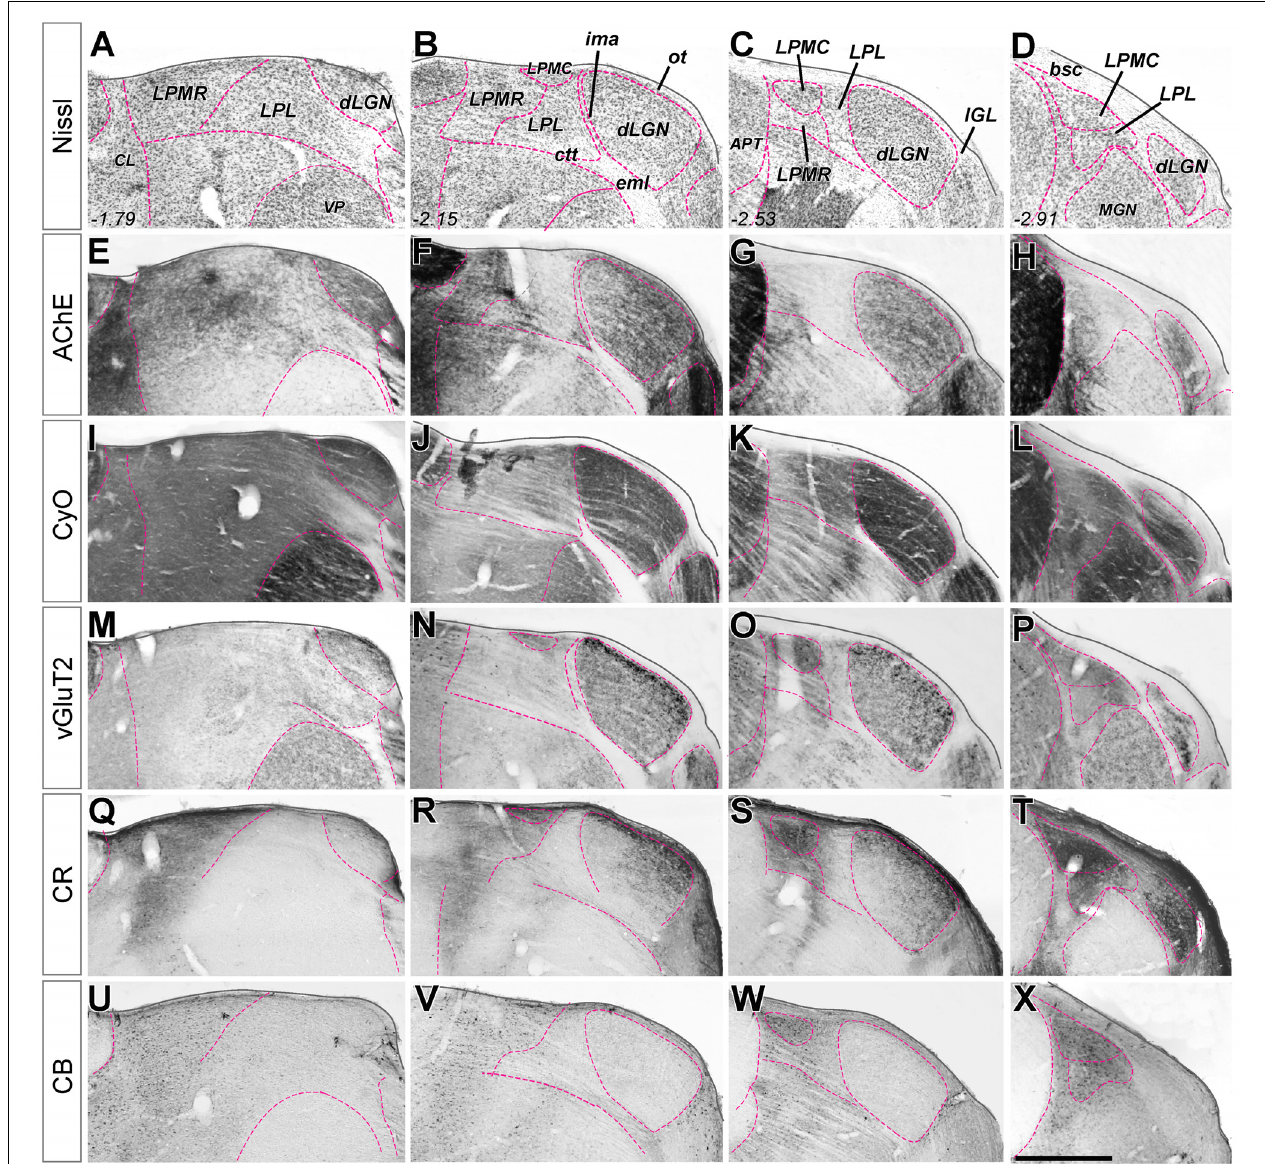
FIGURE 1 | Delineation of visual thalamus nuclei from the combination of multiple stains on coronal sections. (A–D) Nissl-stained coronal sections of mouse visual thalamus. Sections are ordered in the row from rostral (left) to caudal (right). Distance caudal (–) to Bregma (in mm) is indicated in the lower left corner for each level. All nuclei boundaries (purple dashed line) are drawn here on the images, and the nuclei identified, for reference. In (E–X) , only the boundaries that are revealed by the staining at each coronal level are marked with the purple line. (E–H) Parallel coronal sections stained with acetylcholinesterase histochemistry. (I–L) Parallel coronal sections stained with cytochrome C-oxidase histochemistry. (M–P) Parallel coronal sections immunostained for vesicular glutamate transporter type 2. (Q–T) Parallel coronal sections immunostained for calretinin. (U–X) Parallel coronal sections immunostained for Calbindin 28K. Scale bar = 50 µ